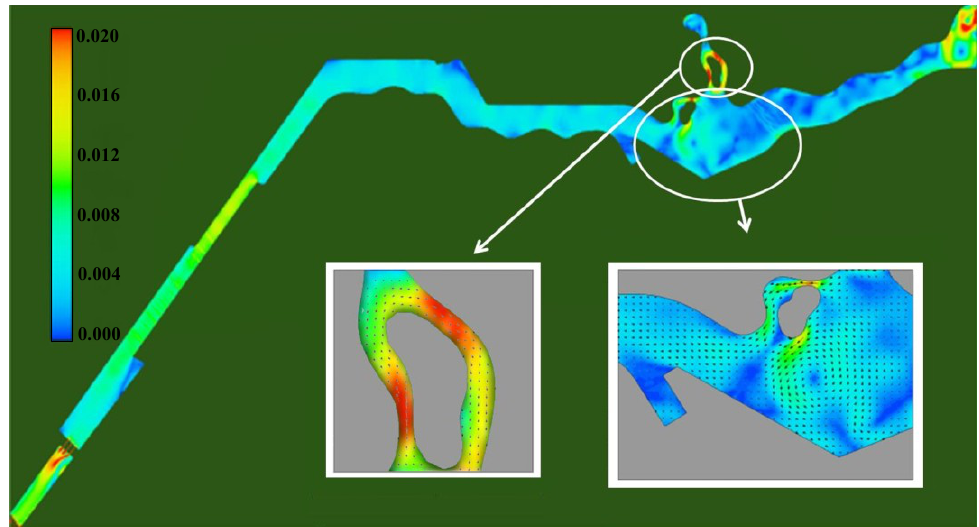
Figure 7. Results of the numerical simulation (velocity distribution (m/s)).